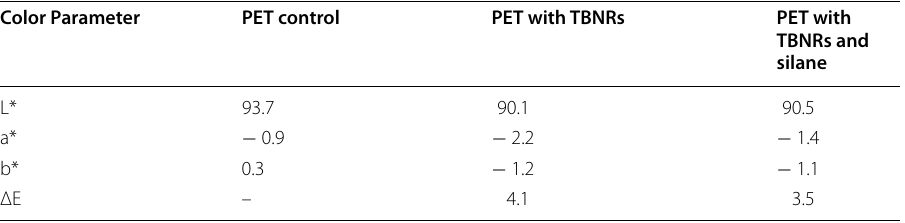
Table 1 Color values of PET Control, PET treated with 5 wt% tungsten bronze nanorods (TBNRs), and PET treated with 5 wt% TBNRs and 0.5 wt% silane Color